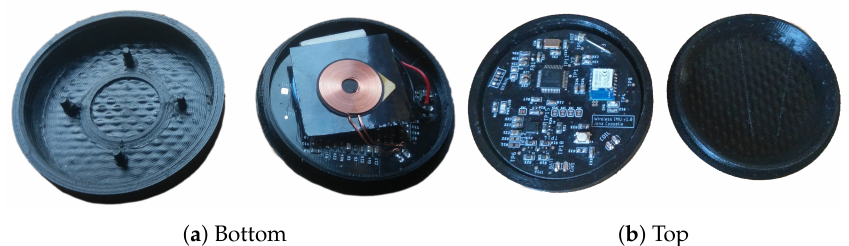
Figure 9. Result: sensor node in the 3D printed case. ( a ) Bottom side: wireless charging coil and battery. ( b ) Topside: IMU, microcontroller, and BLE chip.